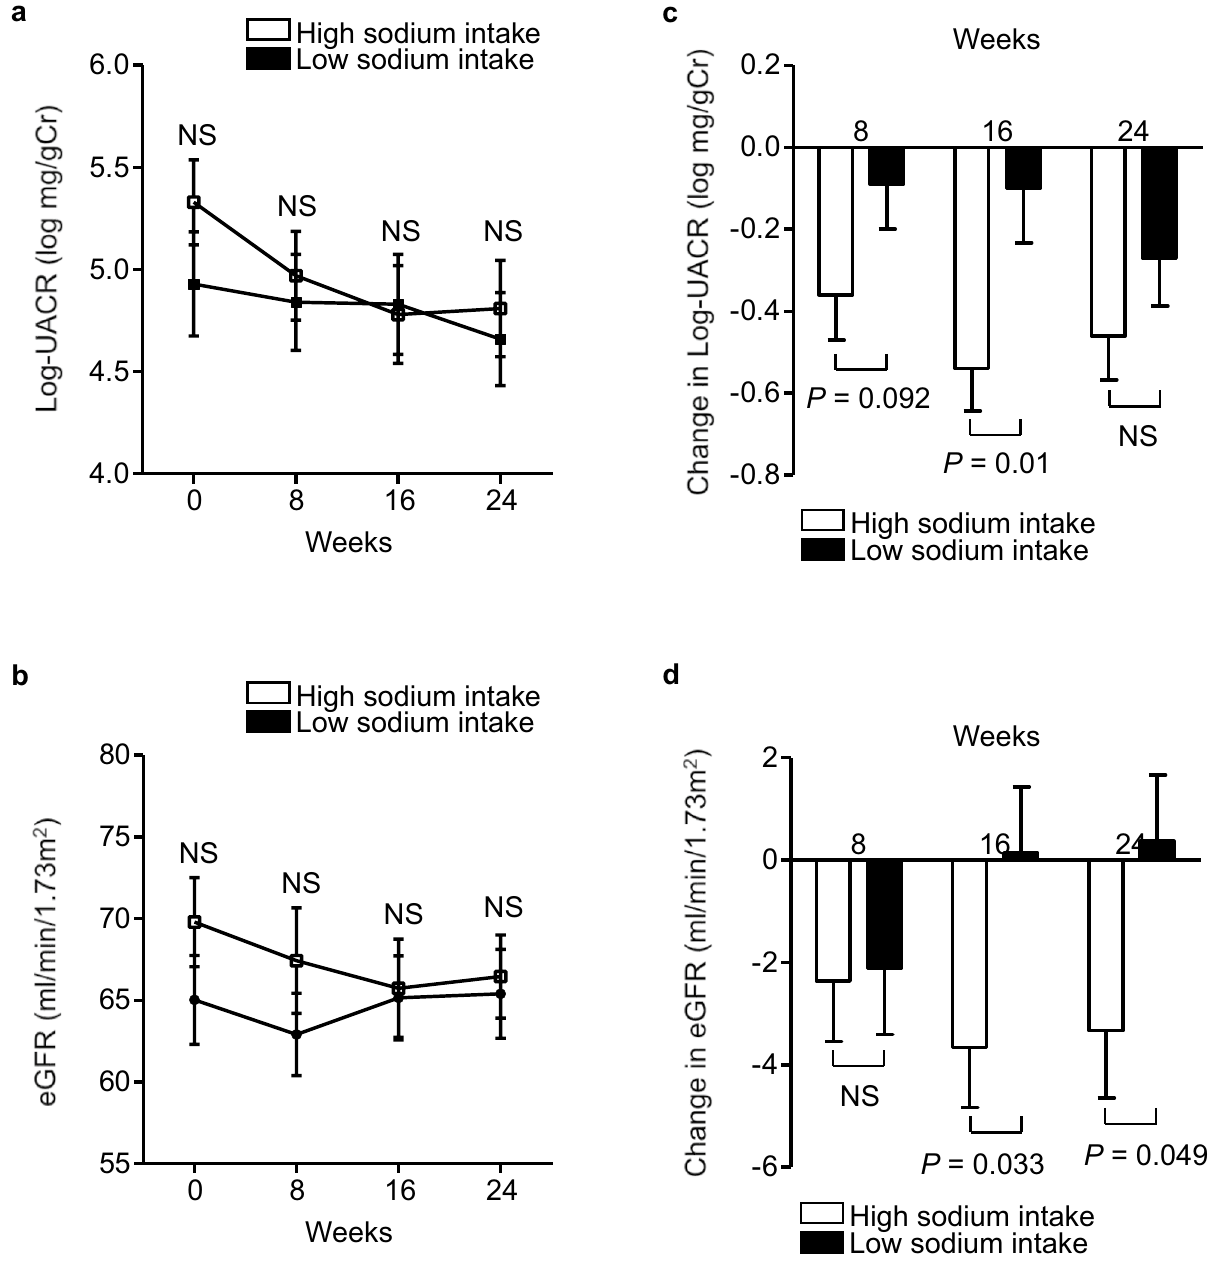
Figure 1. Effects of add-on dapagliflozin therapy on renal endpoints in the HS and LS groups. (a) Natural logarithm of urine albumin-to-creatinine ratio (ln-UACR), and (b) estimated glomerular filtration (eGFR) in dapagliflozin-treated patients during the 24-week study period. Change in (c) ln-UACR, and (d) eGFR during the 24-week study period. Eighty-four DKD patients were allocated to a high sodium intake (HS) group (open square) or a low sodium intake (LS) group (filled square), according to their median urinary sodium- to-creatinine ratio at baseline. Values are mean ± SE. The differences in the effects of dapagliflozin treatment between the two groups were analyzed using unpaired t -tests at each visit. NS not